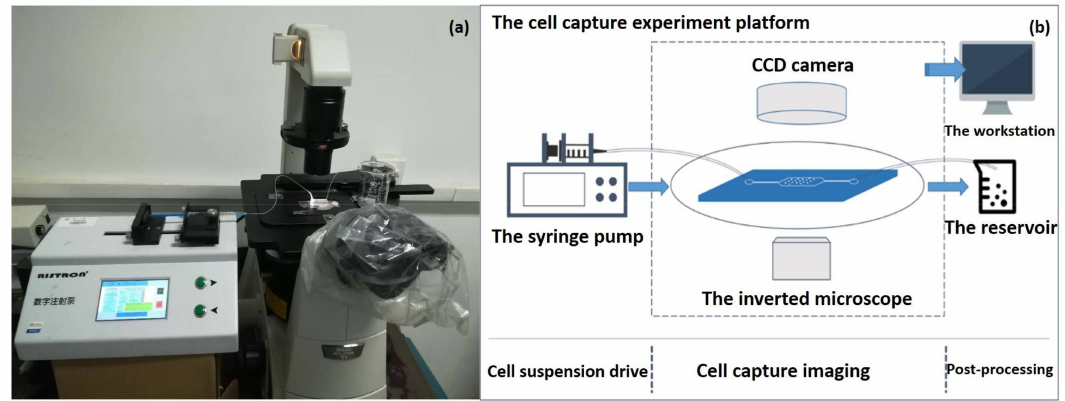
Figure A1. Schematic diagram of the cell capture experiment platform: ( a ) The main equipment used in the experiment; ( b ): The overall cell capture experiment